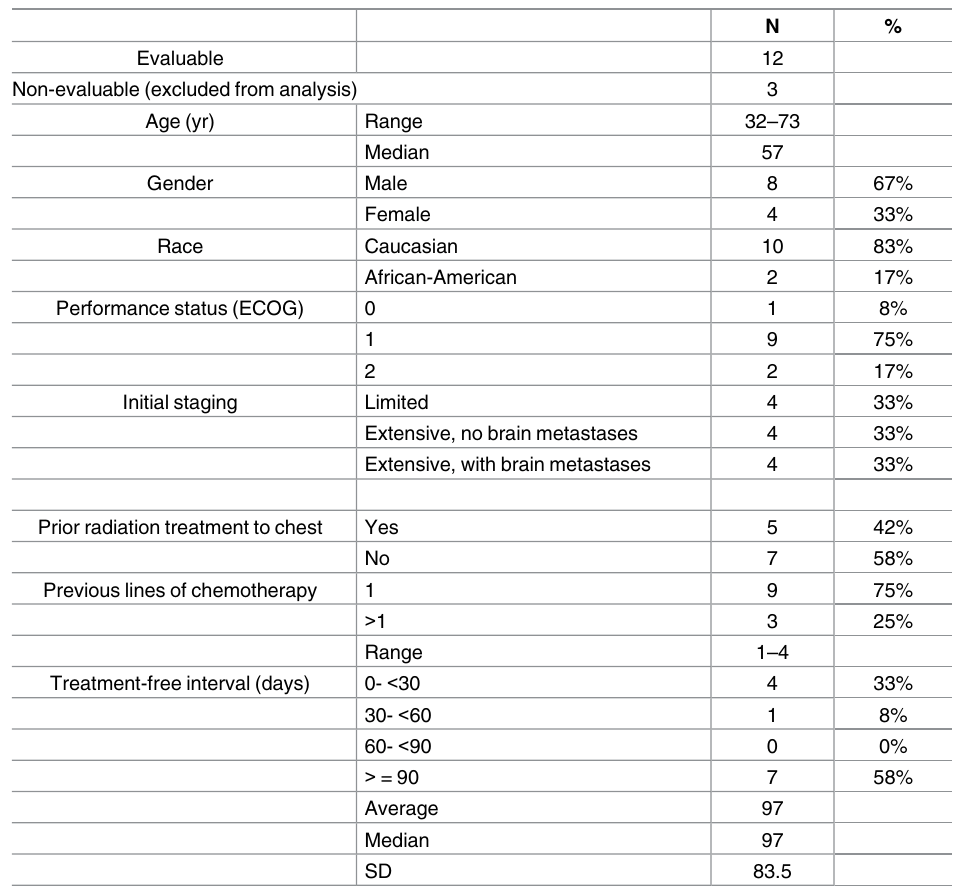
Table 1. Patient